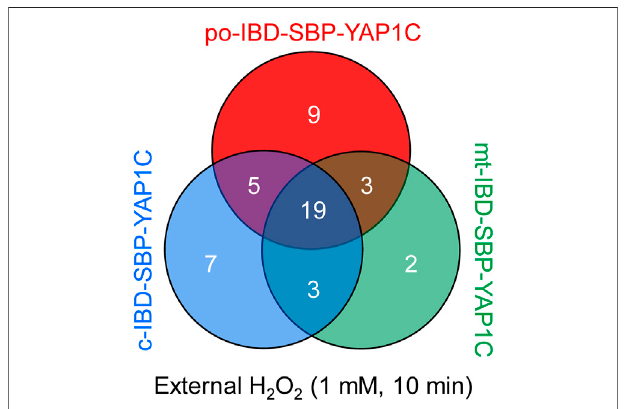
FIGURE 3 | Venn diagram showing the number and overlap of po-, c-, andmt-IBD-SBP-YAP1Cinteractors upontreatmentofFlp-InT-REx293cells with 1 mM H 2 O 2